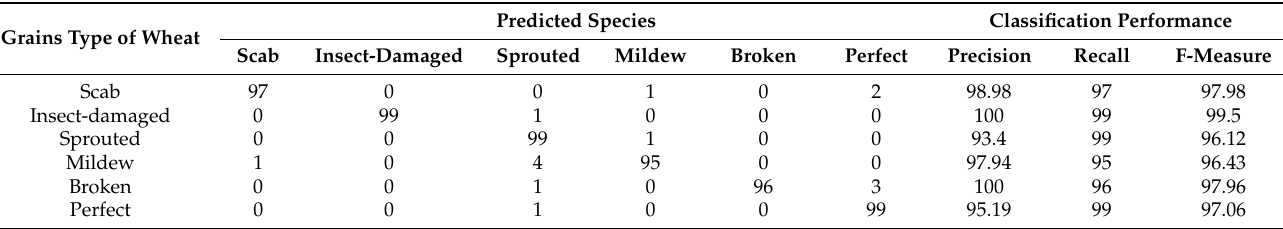
Table 6. Confusion matrix and classification performance of ResNet-50 model with attention. Predicted Grains Type of Wheat